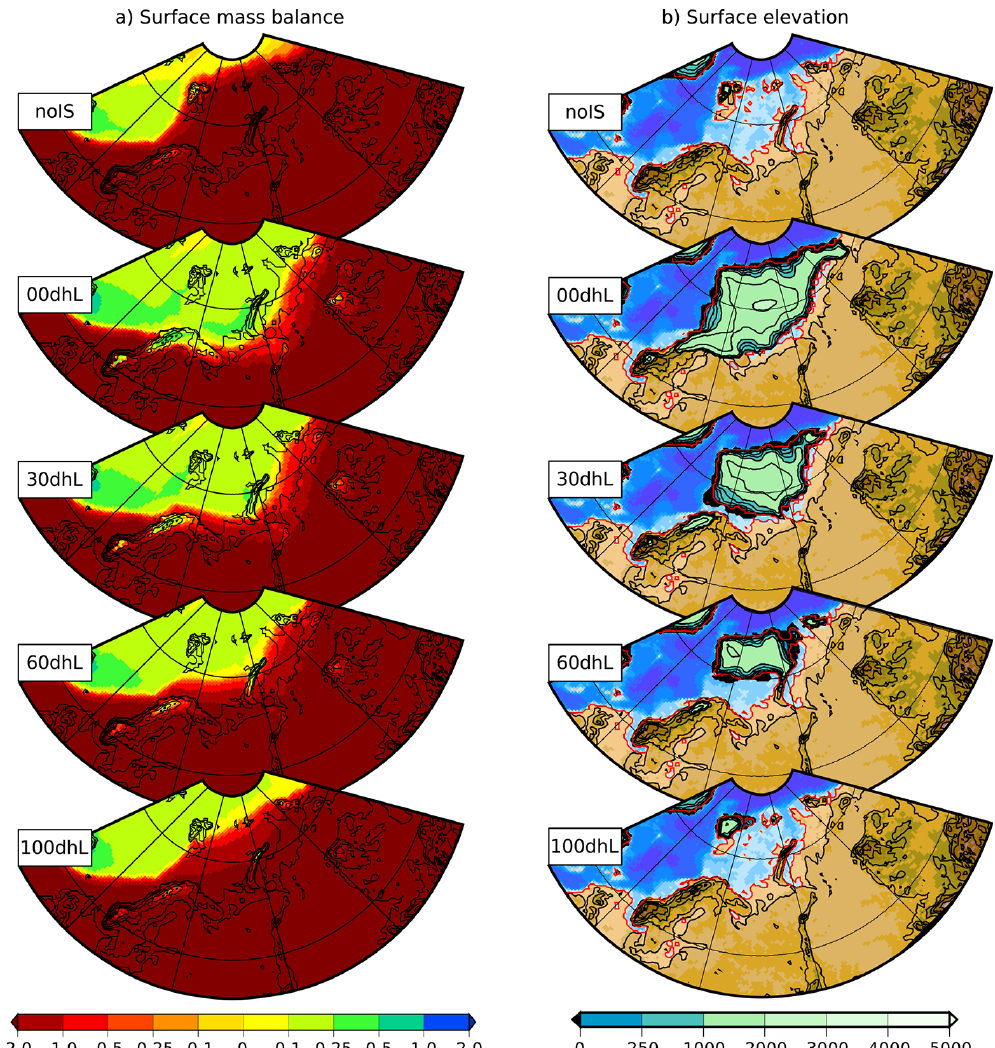
Figure 13. (a) Surface mass balance at the beginning of the simulation (in myr − 1 ) and (b) surface elevation at the end of the simulation computed by the ice-sheet model for the selected experiments (in